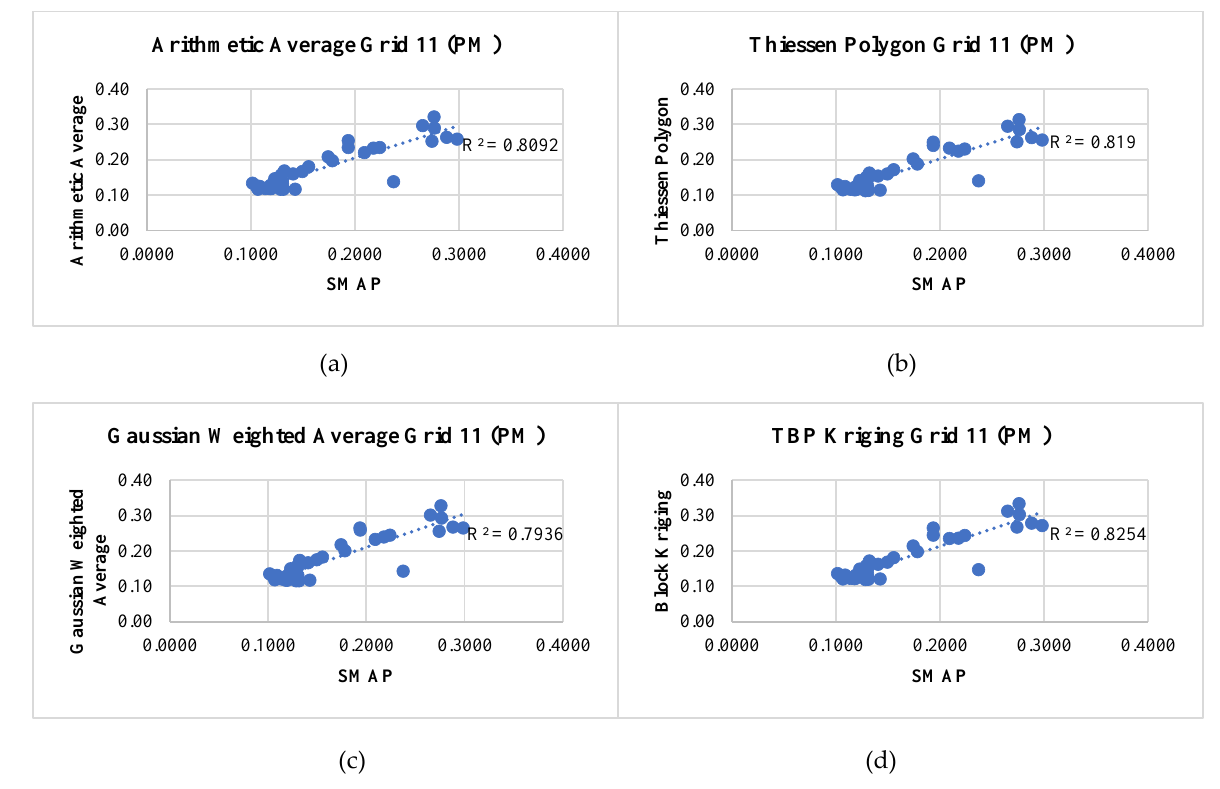
Figure 13. Grid 11 — spatial autocorrelation not detected: correlation plot between the afternoon SMAP data and the four upscaling algorithms. ( a ) arithmetic average; ( b ) Thiessen polygon method; ( c ) Gaussian-weighted average; ( d ) TBP kriging.